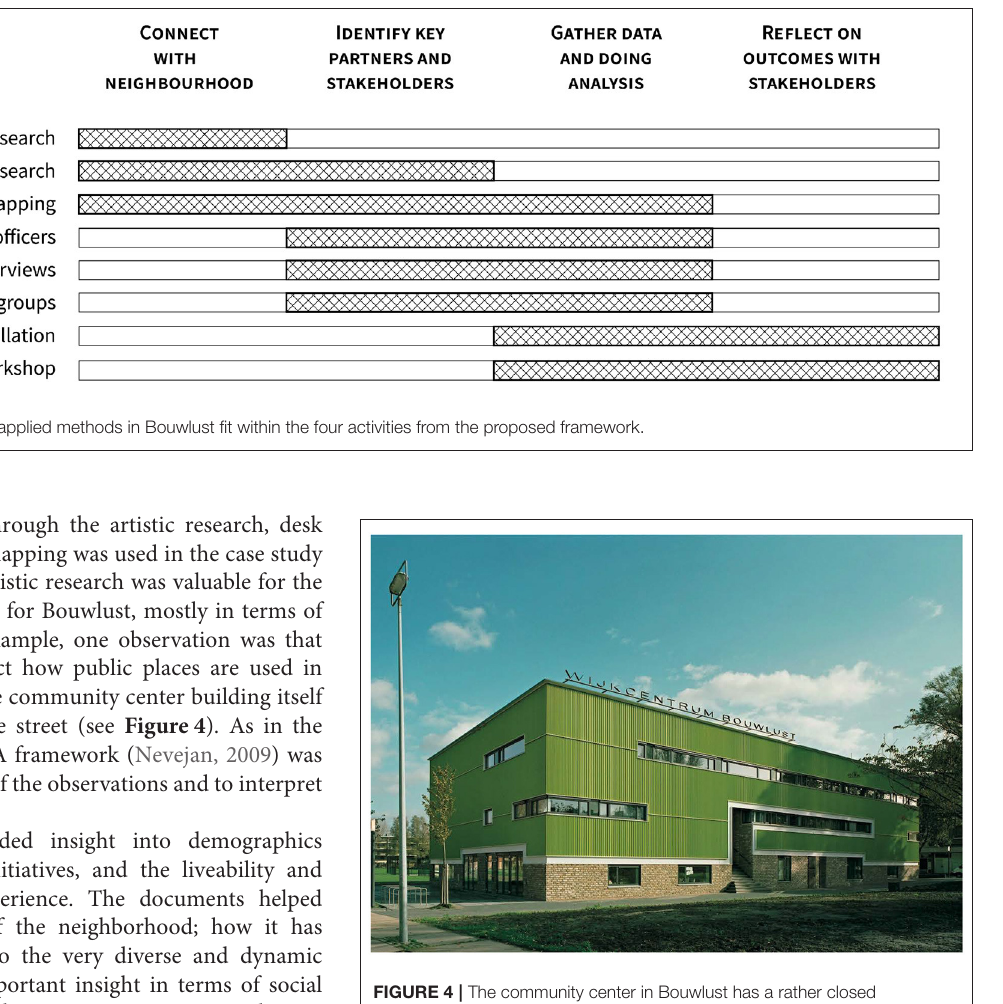
FIGURE 4 | The community center in Bouwlust has a rather closed